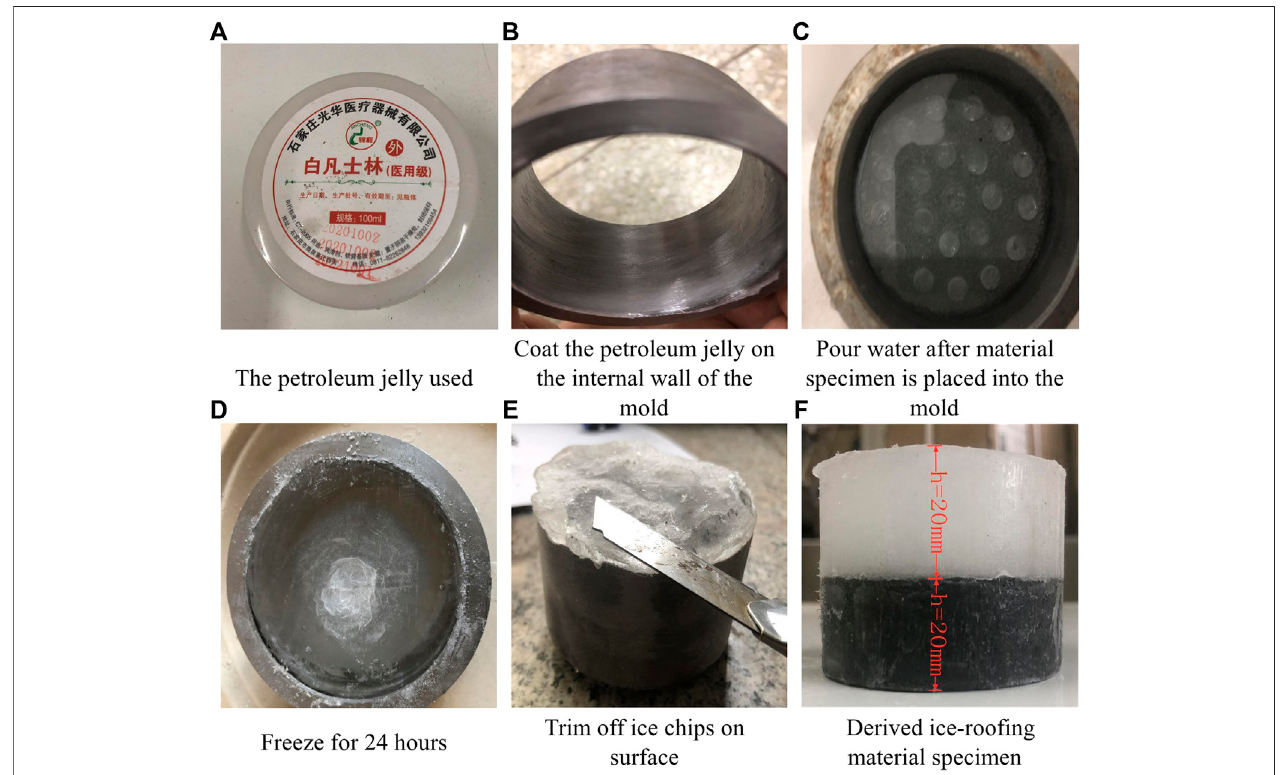
FIGURE 4 | Illustration of specimen preparation: (A – F) show the sequential steps for making the combined ice-roo fi ng material specimens.